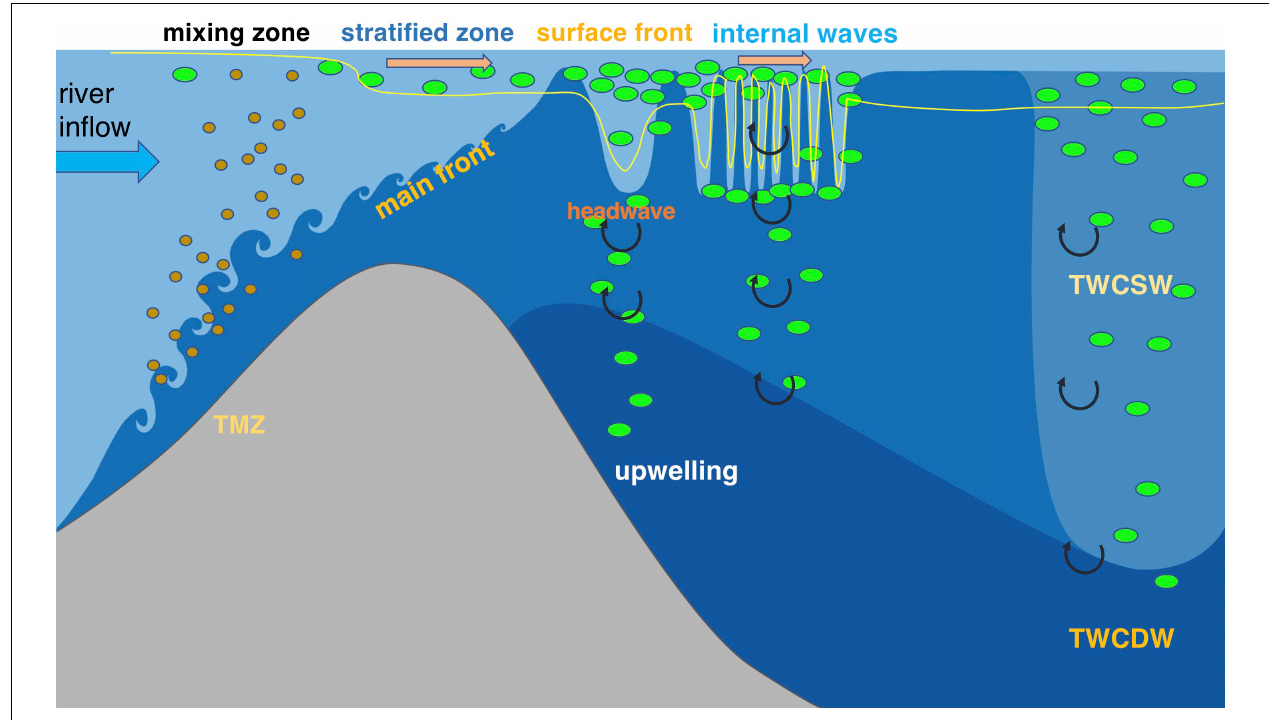
FIGURE 9 | Schematic diagram of the multi-scale physical controls on the phytoplankton biomass and associated biogeochemical processes in the Changjiang Estuary and adjacent coastal area. The green dots represent phytoplankton, and brown dots denote sediment particles. The blue thick arrow represents river inflow, and the orange thick arrows represent currents. The yellow thin line illustrates the euphotic layer depth. The curled arrows denote vertical mixing. The ecosystem production is initialized by the development of subsurface stratification related to the main plume front seaward of the TMZ, while significant increase in phytoplankton biomass does not occur in this area since algal growth needs time. Phytoplankton blooms appear at the outcrop location of the main front due to mass convergence that increases the phytoplankton retention time and downwelling that enhances light penetration. Front-released internal waves can possibly induce phytoplankton blooms by transitioning the plume currents from supercritical to subcritical, thus increasing the phytoplankton retention, and by promoting vertical mixing that can entrain nutrients from the upwelled oceanic waters into the surface layer.